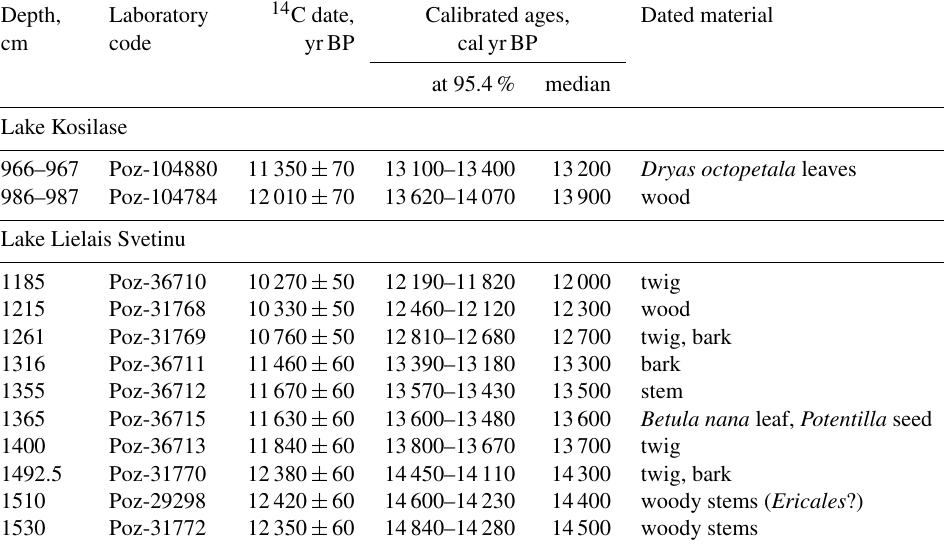
Table 1. List of 14 C dates.